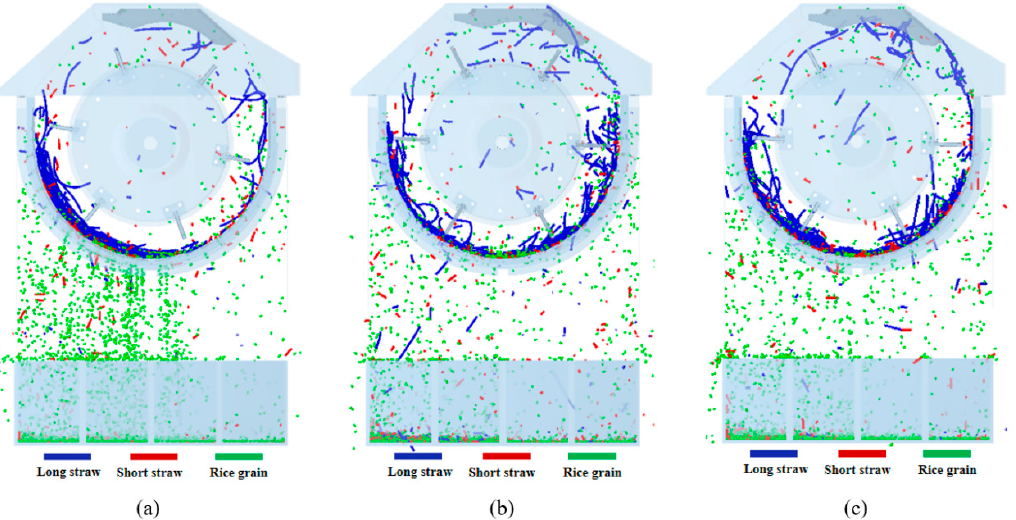
Figure 8. Circumferential distribution of rice mixture in the concentric threshing device at 1 s: ( a ) single threshing gap of 15 mm; ( b ) single threshing gap of 10 mm; ( c ) multi-threshing gaps of 10 mm and 15 mm.